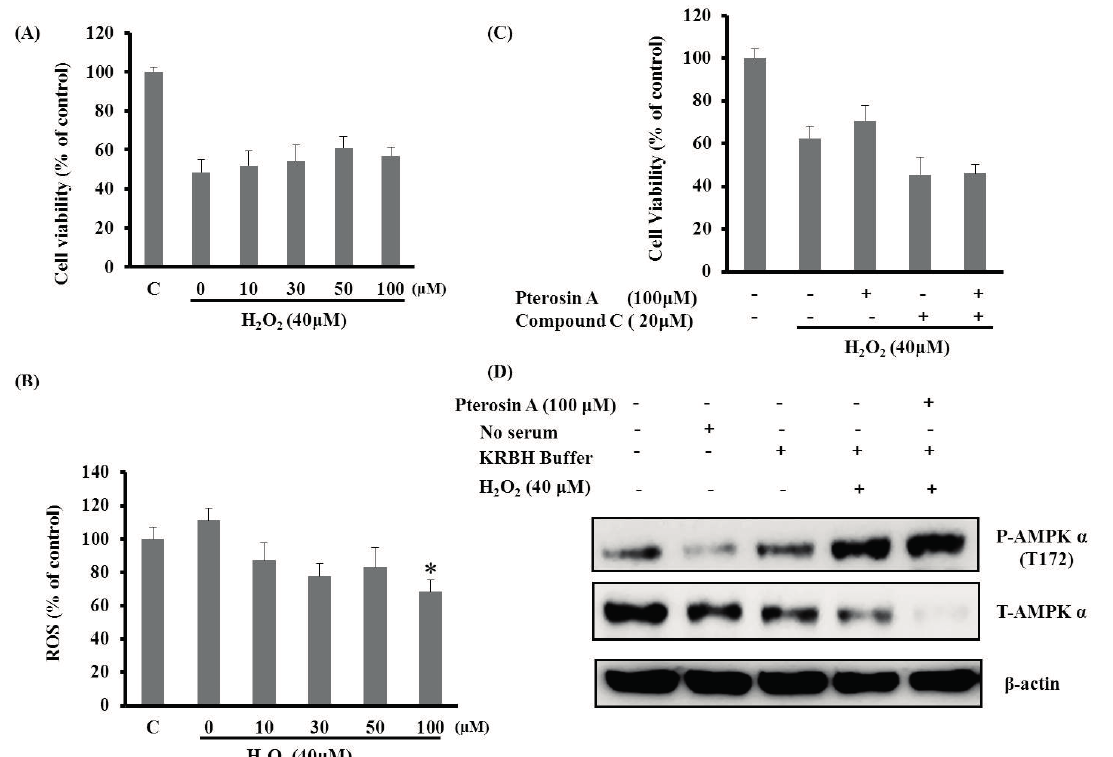
Figure 6. Pterosin A protected against H 2 O 2 -induced reactive oxygen species (ROS) cell damage through adenosine monophosphate-activated protein kinase (AMPK)